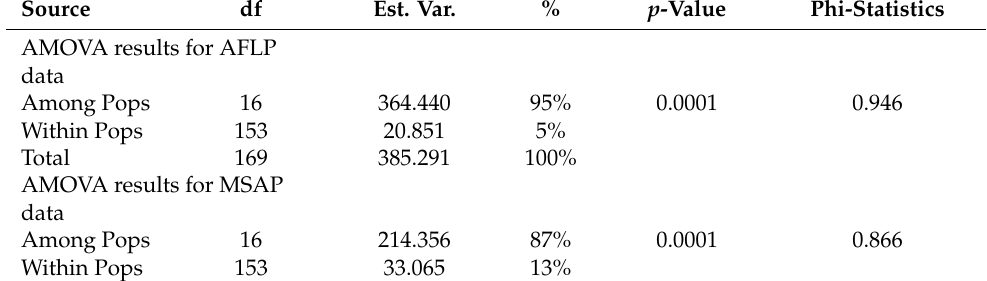
Table 3. AMOVA results of amplified fragment length polymorphism (AFLP) data and methylation sensitive amplification polymorphism (MSAP) data of the natural population of D. angustifolia.